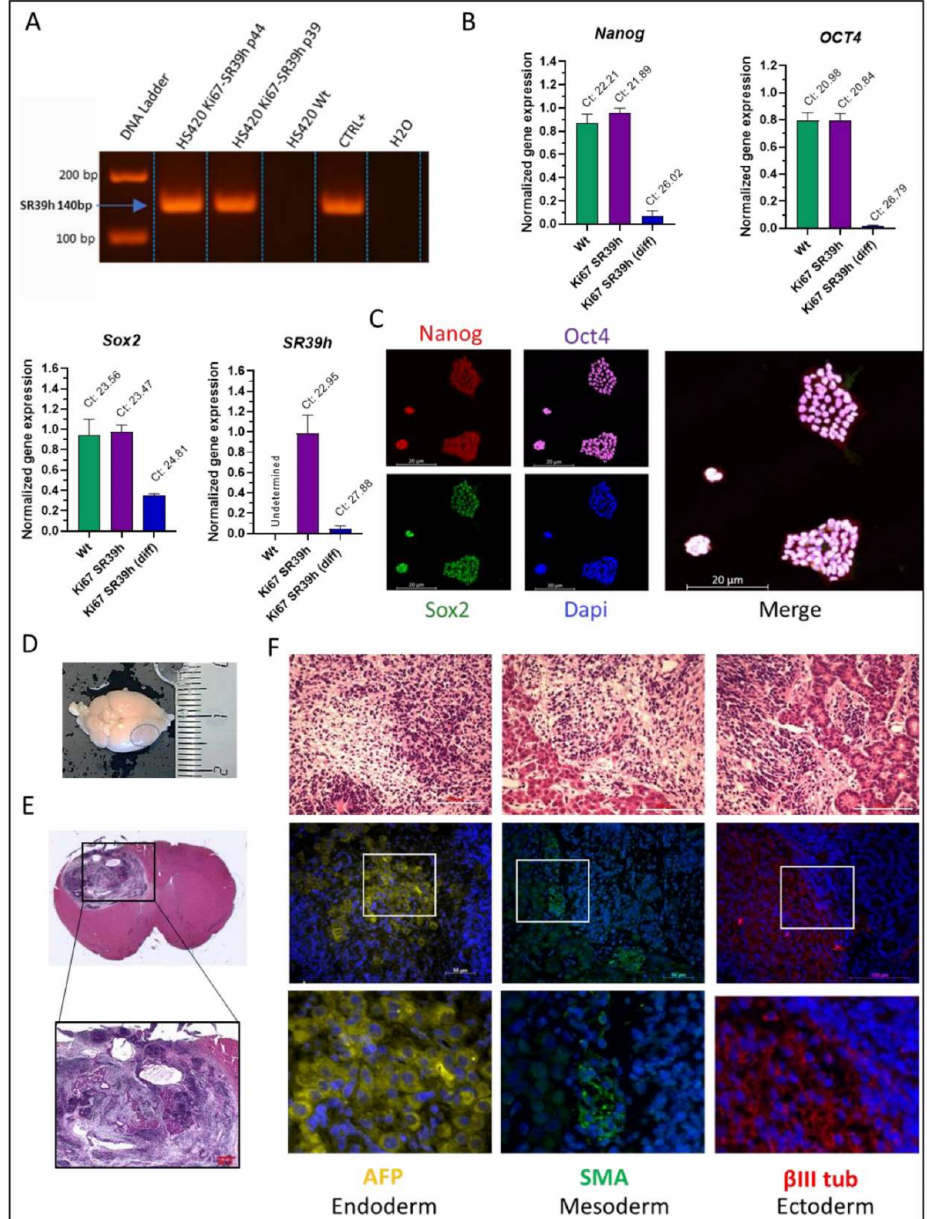
Figure 2. Characterization of the SR39h-expressing hESC line. ( A ) PCR analysis of SR39h transgene insertion in genomic DNA. ( B ) RT-PCR analysis of the expression of pluripotency genes ( n = 3), OCT-4, NANOG, SOX2 , and SR39h in SR39h-expressing hESC (undifferentiated and differentiated), as well as control wild type cells (undifferentiated). ( C ) Immunofluorescence staining of pluripotency markers (OCT4, SOX2, NANOG), nuclei were counterstained with Hoechst. The merge panel consists of all four staining. Scale bar 20 µ M. ( D ) Macroscopically visible teratoma (blue circle) after brain extraction from the skull bone. ( E ) Hematoxylin and eosin staining of coronal slice of mice brain. ( F ) Upper panel; coronal sections brain with teratoma stained with hematoxylin and eosin. Scale bar 100 µ M. Lower panels; immunostaining: α -fetoprotein (AFP) for endoderm-derived tissue, α -smooth muscle actin (SMA) for mesoderm-derived tissue and Beta-III tubulin ( β III tub) for ectoderm-derived